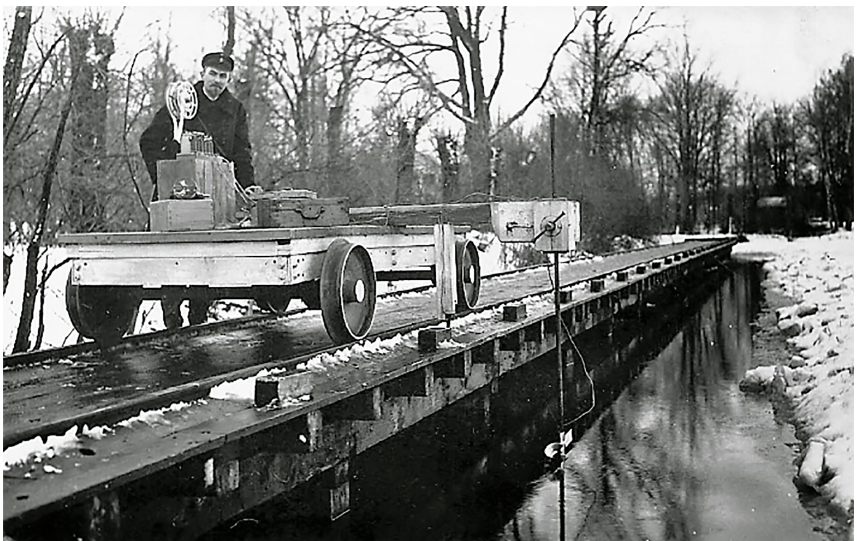
Figure 1. Steponas Kolupaila on Kaunas hydrometric instruments calibration field laboratory in 1926 (Keliauk.info,